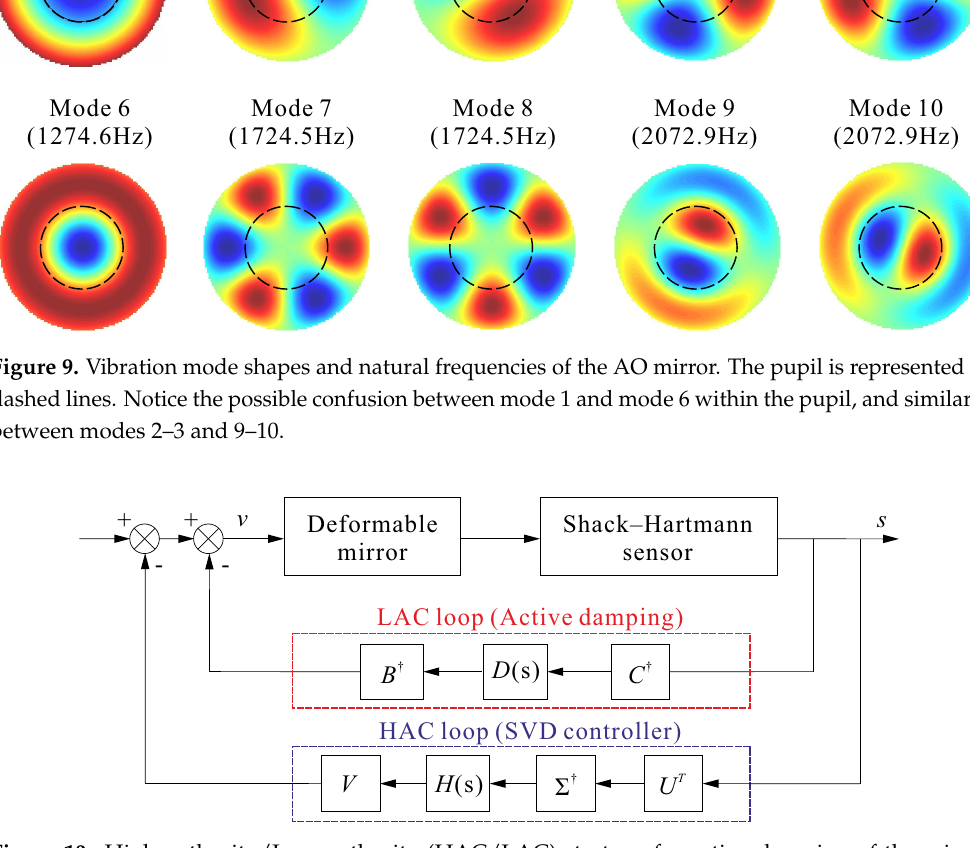
Figure 10. High authority/Low authority (HAC/LAC) strategy for active damping of the mirror. The shape control loop (HAC) is supplemented by a modal active damping (LAC) of the critical low frequency